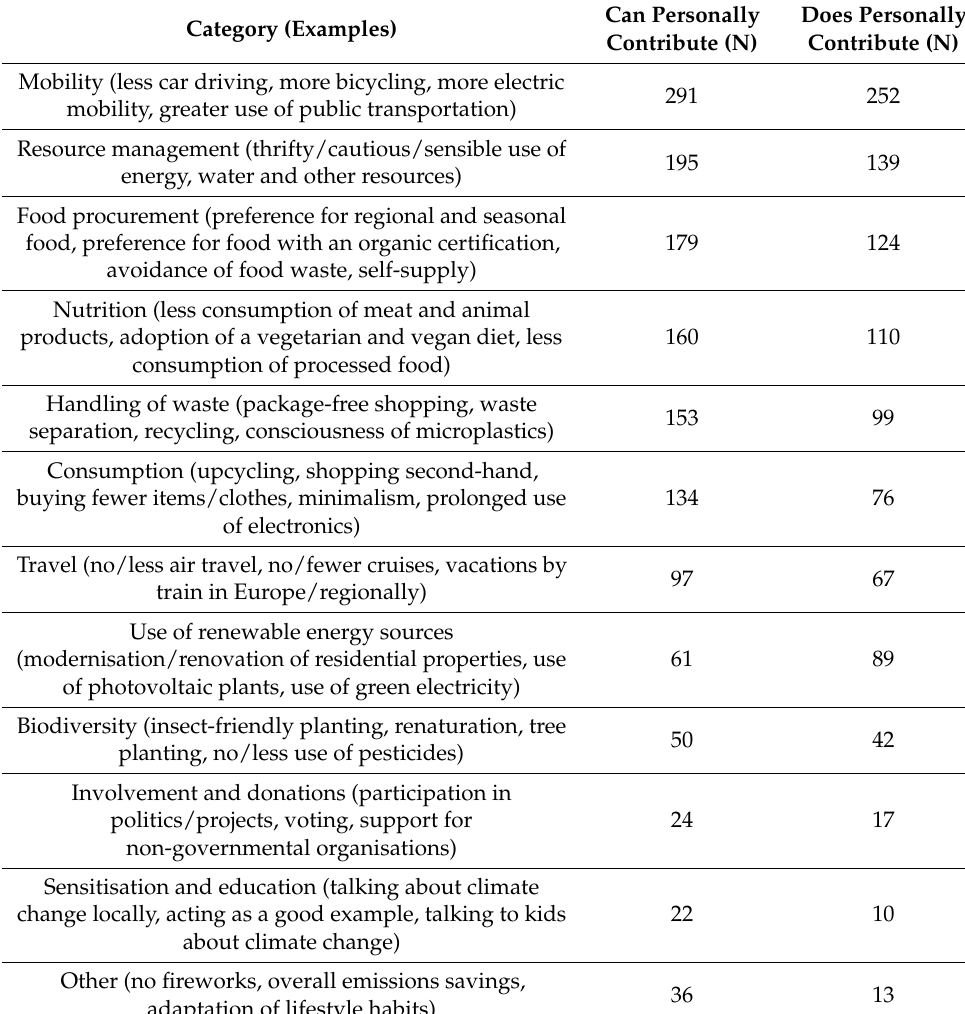
Table 4. Individual options for action against climate